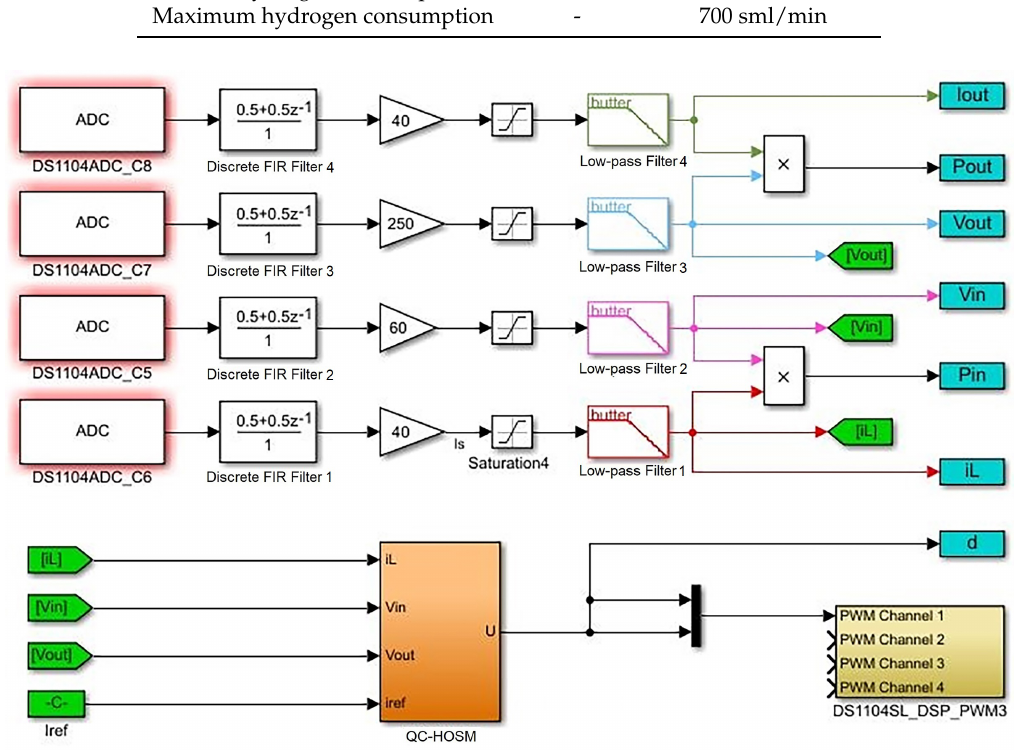
Figure 6. Connection signals with